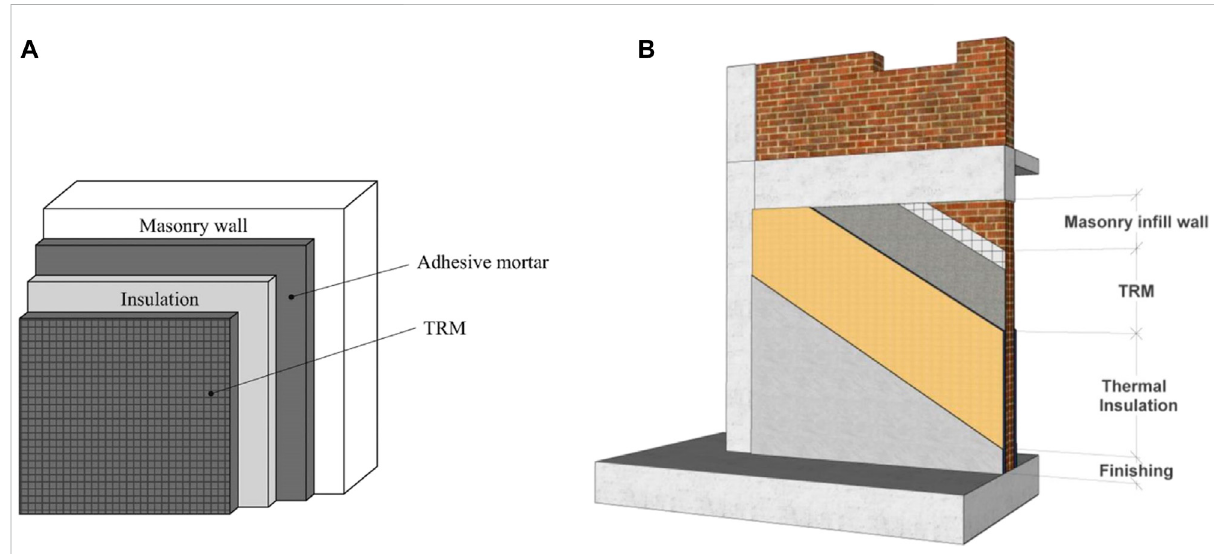
FIGURE 10 Scheme of the TRM structural and energy retro fi tting solution: (A) masonry wall (Trianta fi llou et al., 2018) ; (B) RC frame (Pohoryles et al.,